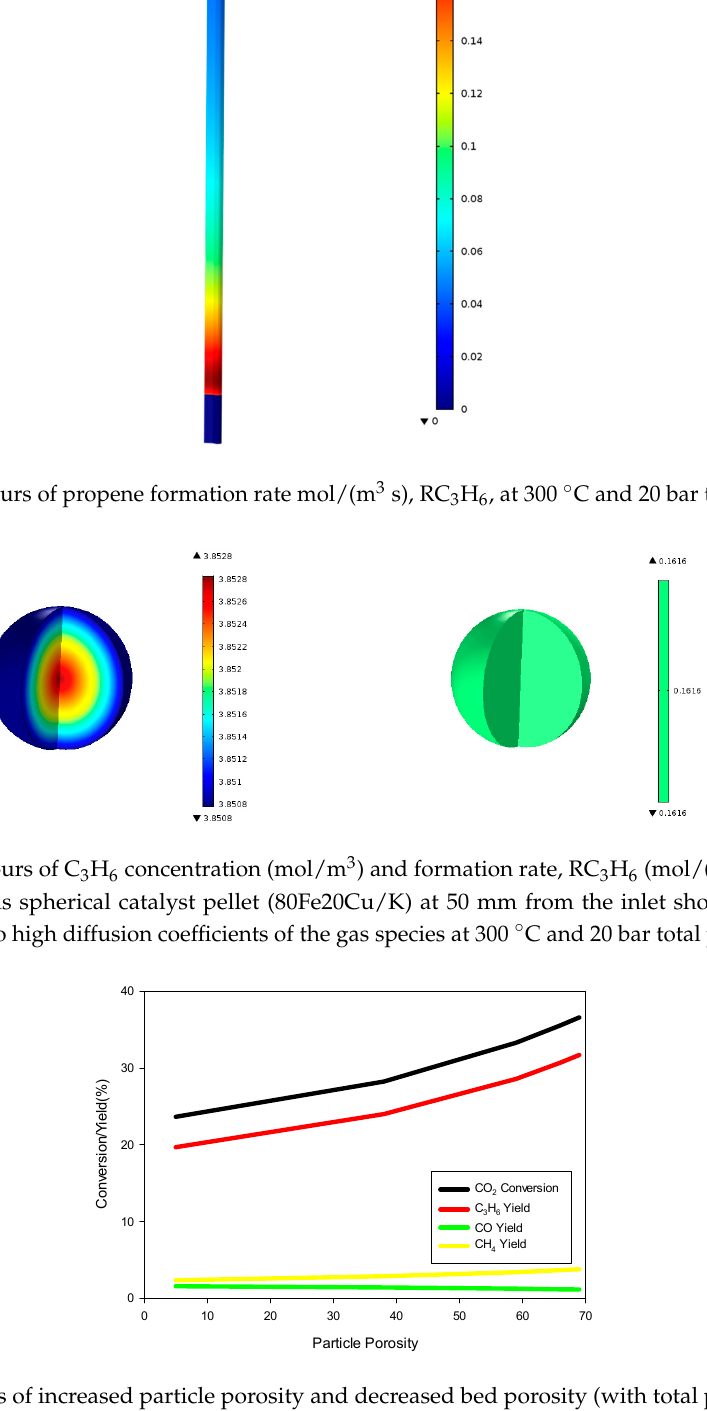
Figure 7. Effects of increased particle porosity and decreased bed porosity (with total porosity fixed at 69.7%) on percent CO 2 conversion (black), and percent C 3 H 6 (red), CH 4 (yellow), and CO (green) at the reactor outlet as predicted by the model for a fixed 20 g of 80Fe20Cu/K catalyst at 300 °C and 20 bar total pressure.